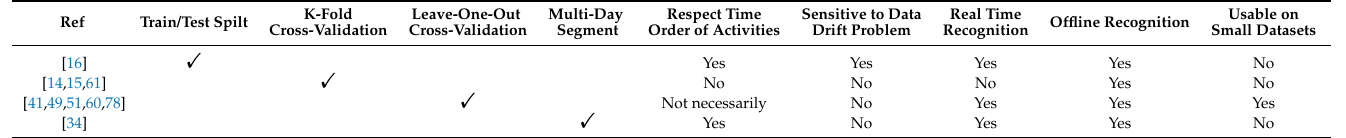
Table 5. Summary of methods for evaluating activity recognition